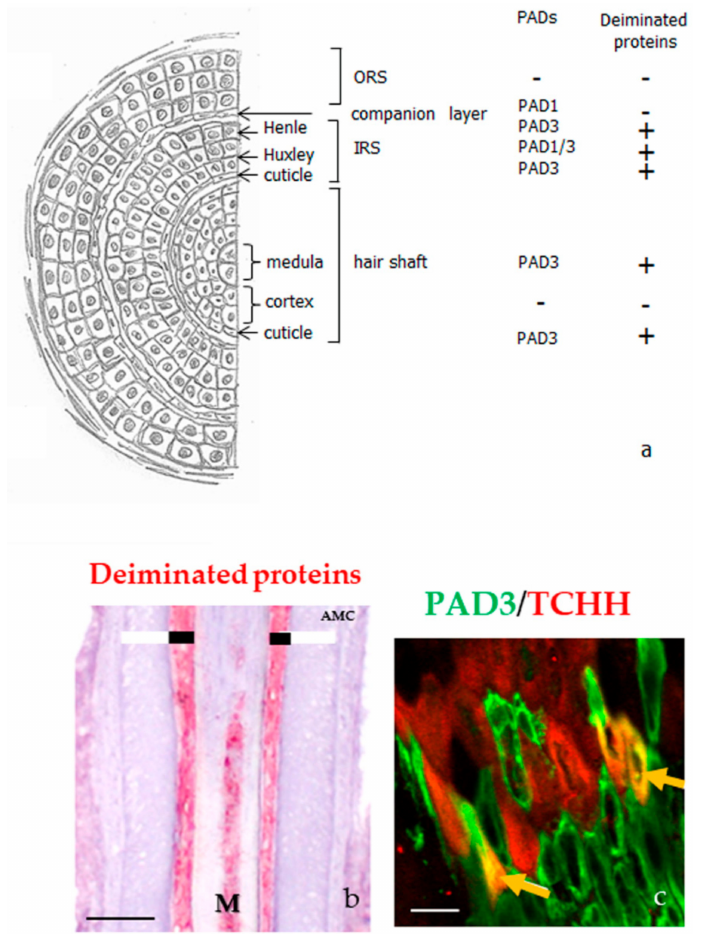
Figure 4. PADs and deiminated proteins in the hair follicles. ( a ) Schematic representation of a hair follicle section and detection of both PADs and deiminated proteins, as reported in [26,27]. IRS, inner root sheath; ORS, outer root sheath. ( b ) Immunodetection of deiminated proteins (red) with the anti-modified citrulline antibody in the medulla (M) and the inner root sheath (large black line) of a normal human hair follicle. The outer root sheath is indicated with a large white line. ( c ) Immunofluorescence detection of PAD3 (green) and trichohyalin (TCHH, red). A yellow staining (yellow arrows) corresponds to colocation of the two proteins. Bar = 50 µ m ( b ) and 100 µ m ( c